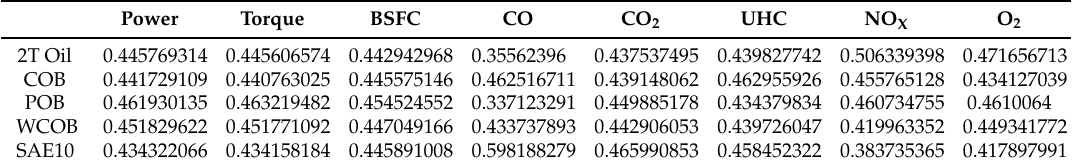
Table 6. The dimensionless decision matrix.